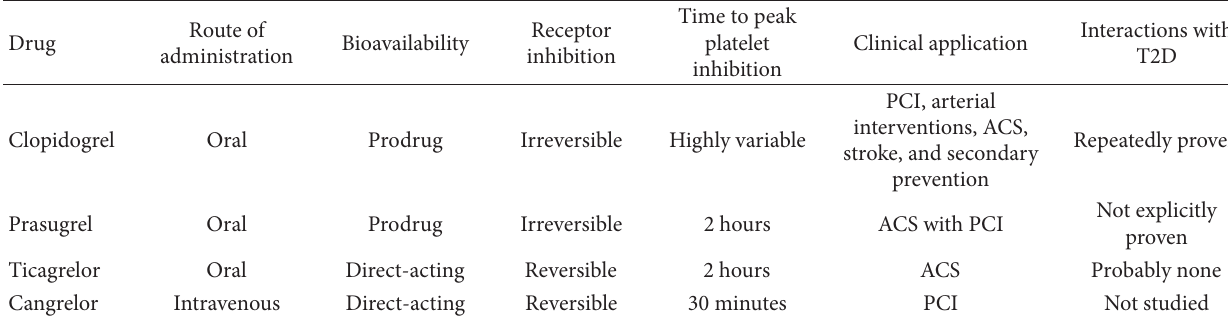
Table 1: ADP receptor blockers in current clinical